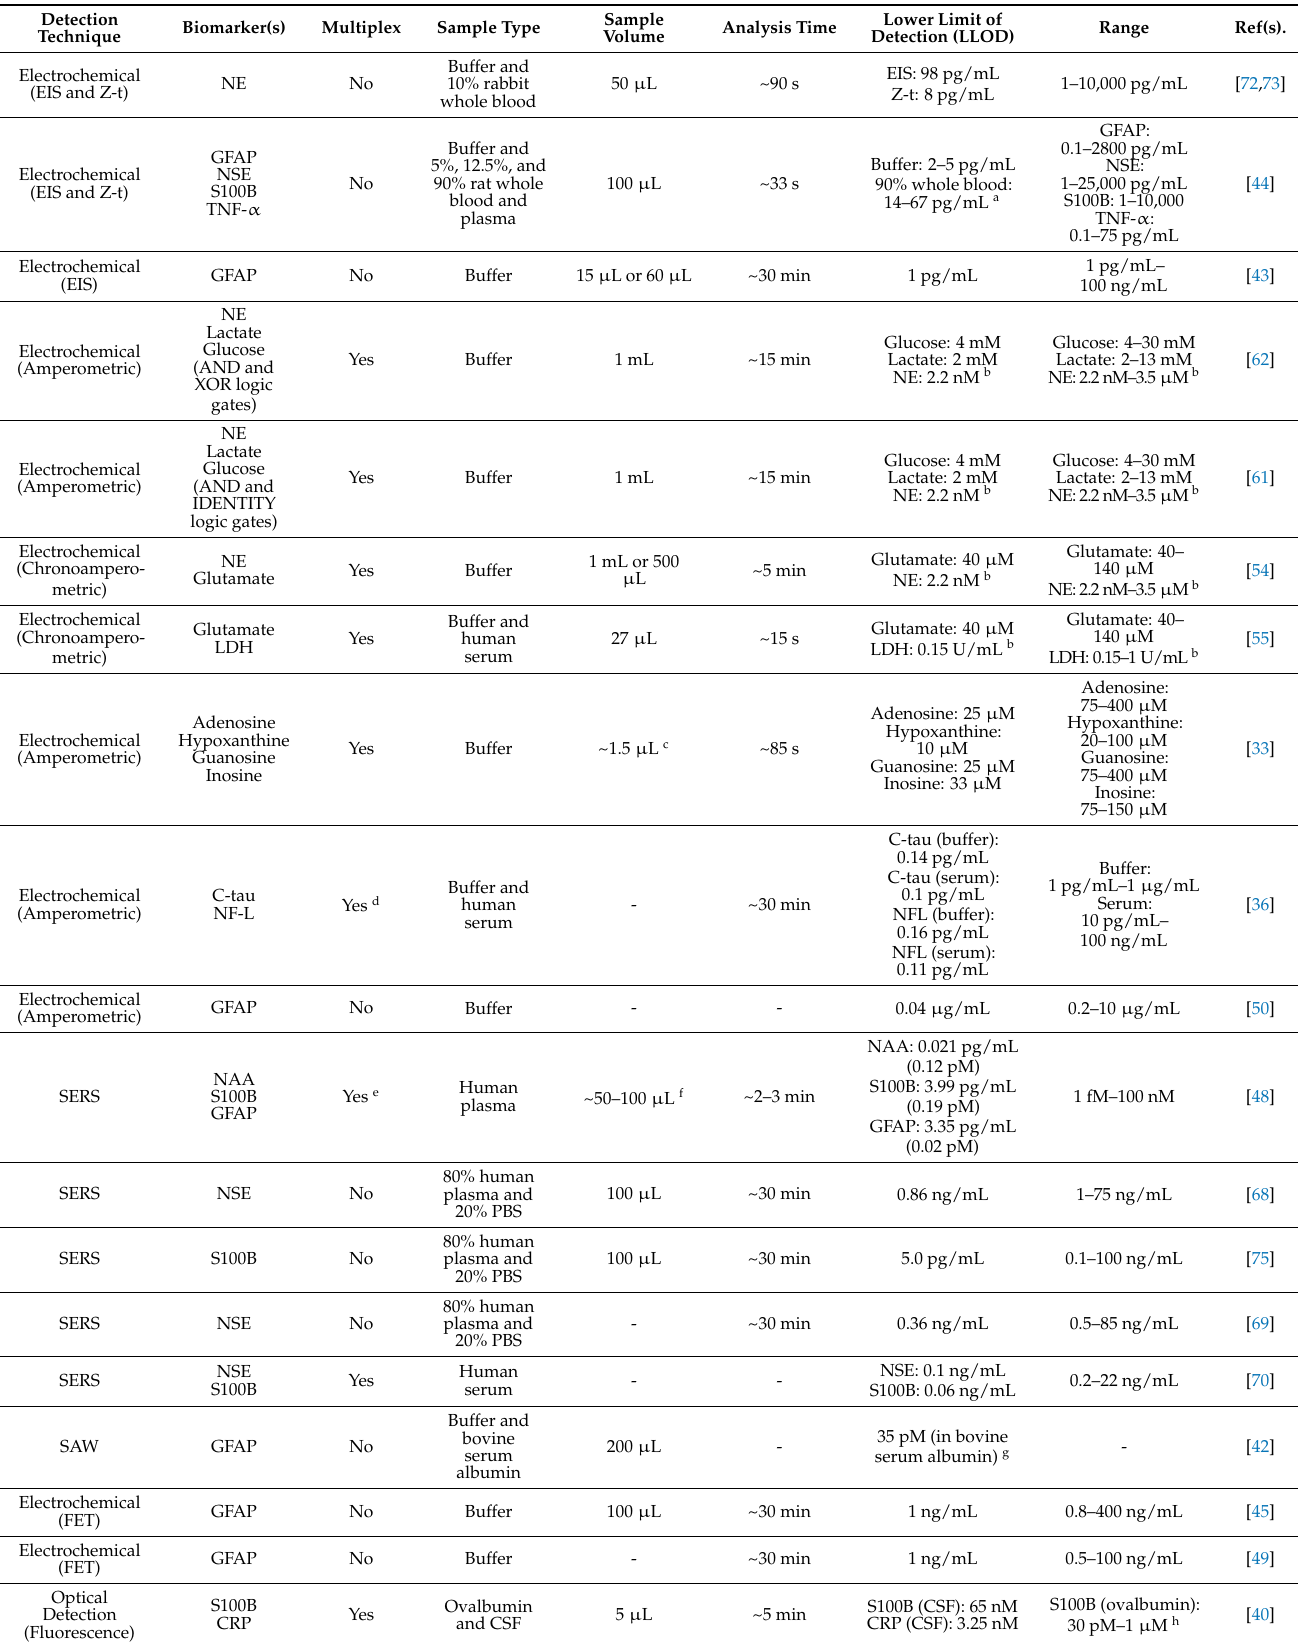
Table 2. Summary of early-stage sensors for traumatic brain injury protein biomarker